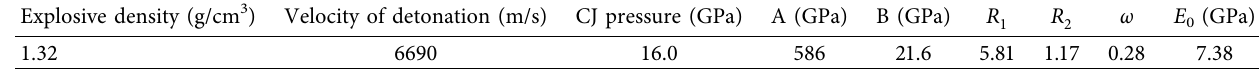
Table 2: Parameters of explosive [21].